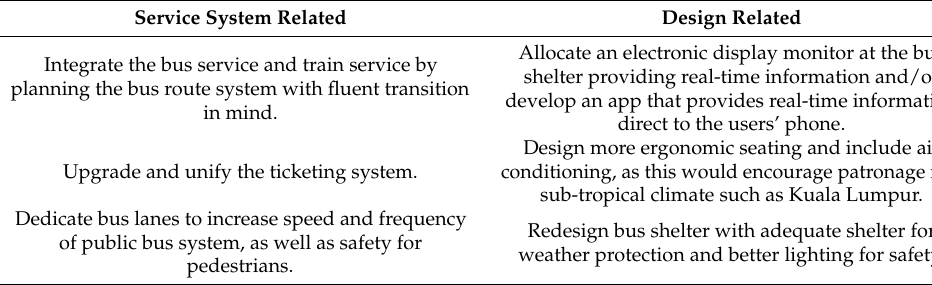
Table 4. Service system and design improvements categorised by the questionnaire. Service System